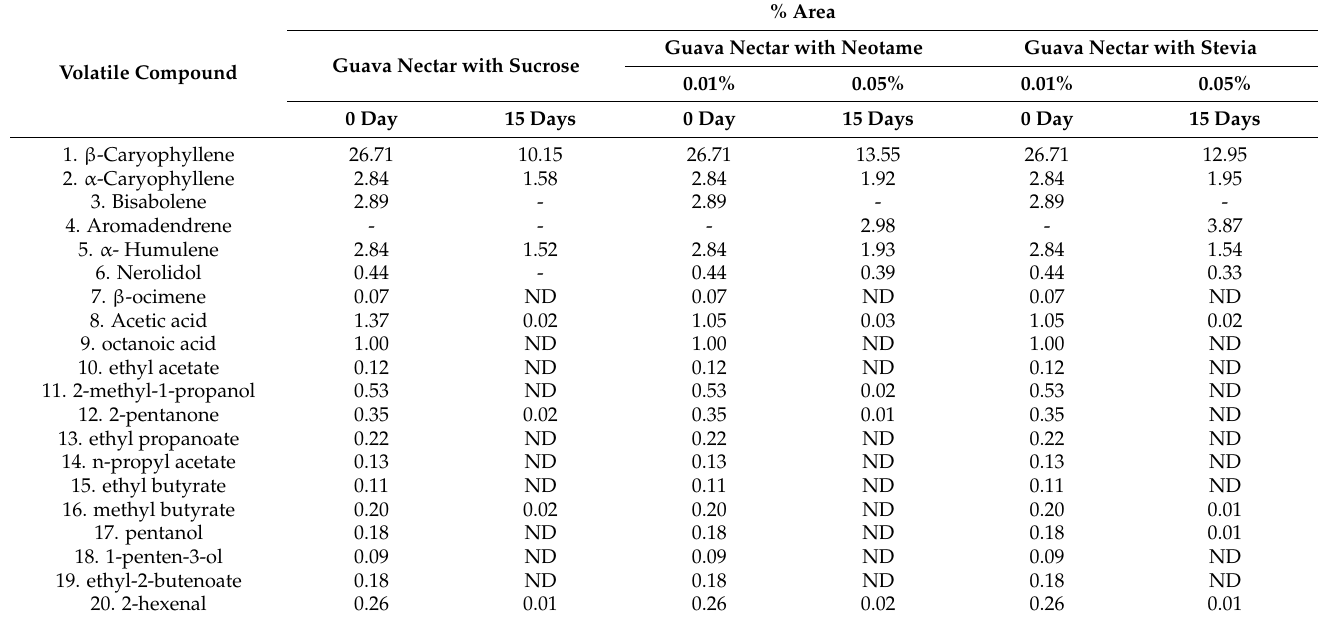
Table 6. Description of the volatile compound in fresh and sweetened guava juice at 0 and 15 days of storage at 5 ◦